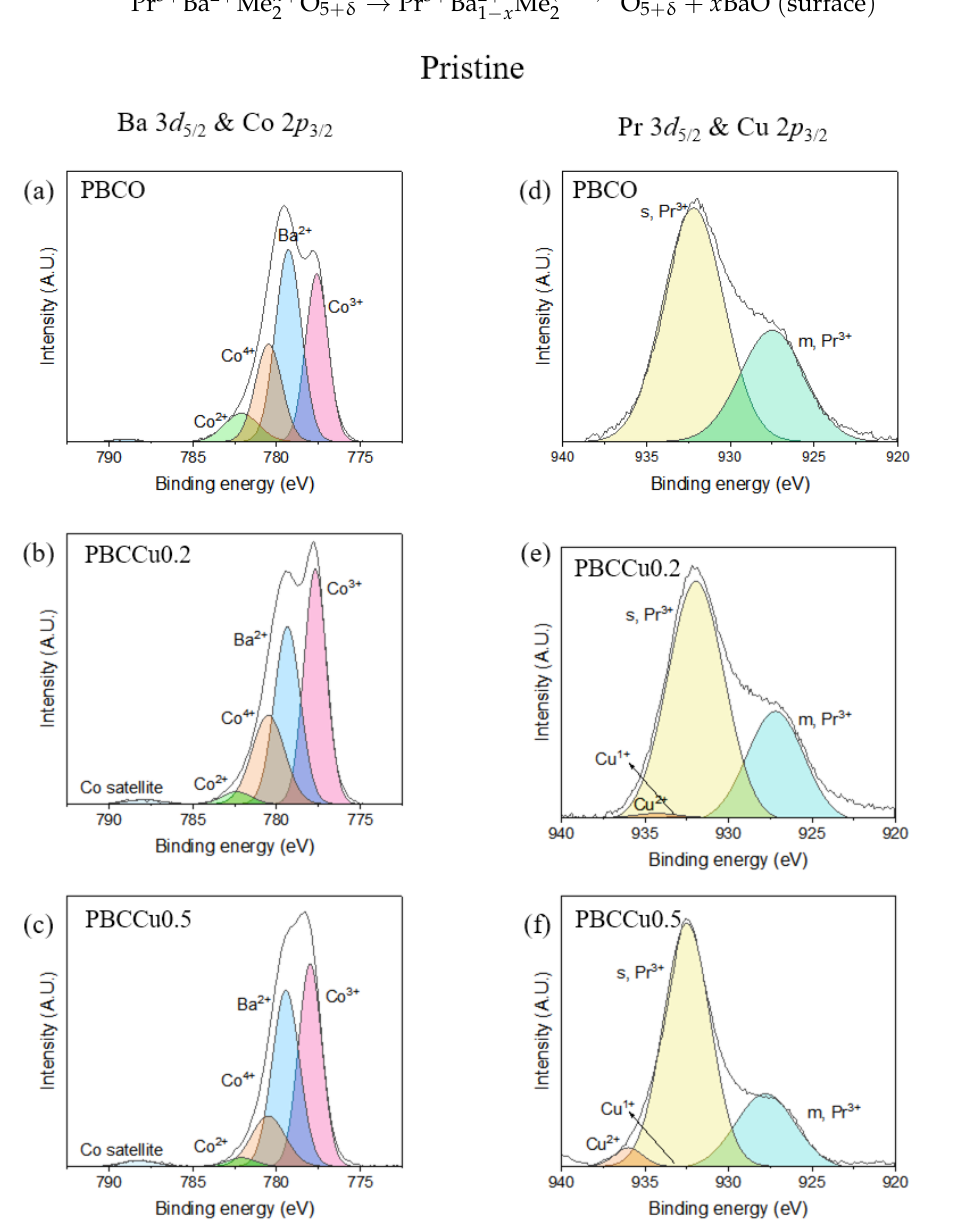
Figure 2. Core-level spectra (black solid line) together with the fit results (colored area) for pristine PBCCu x , Ba 3d 5/2 and Co 2p 3/2 : ( a ) PBCO; ( b ) PBCCu0.2; ( c ) PBCCu0.5, Pr 3d 5/2 and Cu 2p 3/2 ; ( d ) PBCO; ( e ) PBCCu0.2; ( f ) PBCCu0.5.